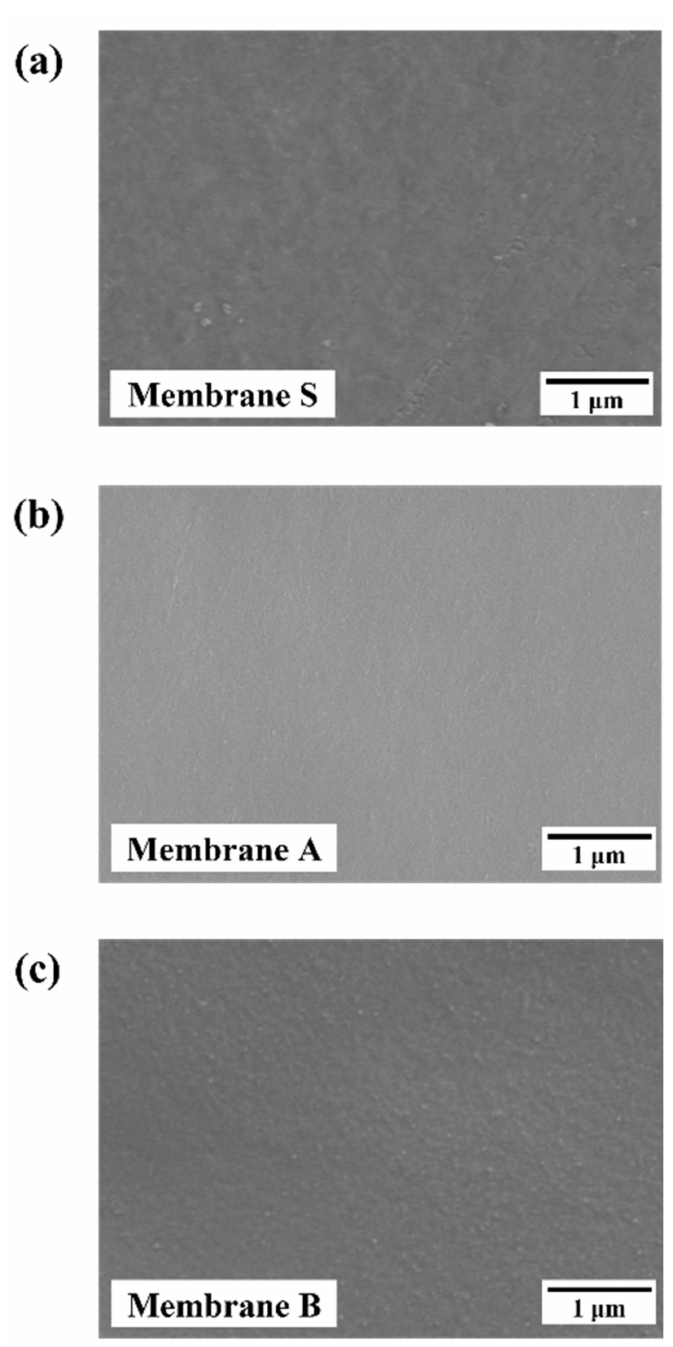
Figure 4. Top-surface SEM micrographs of γ -Al 2 O 3 tight ultrafiltration (UF) membranes: ( a ) mem- brane S (without the addition of PVA); ( b ) membrane A (addition of PVA after peptization); and ( c ) membrane B (addition of PVA before